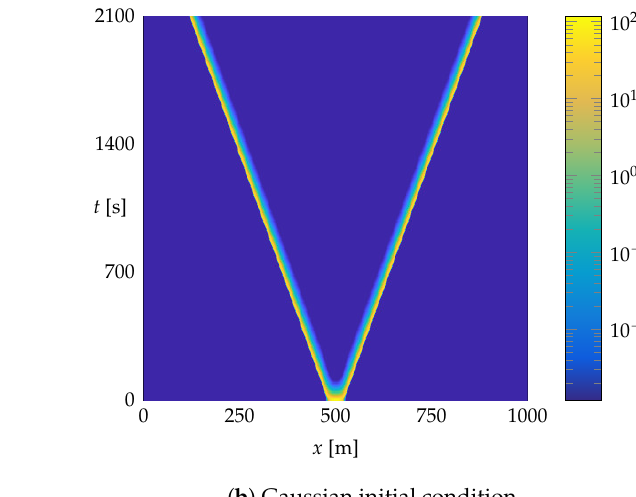
( b ) Gaussian initial condition